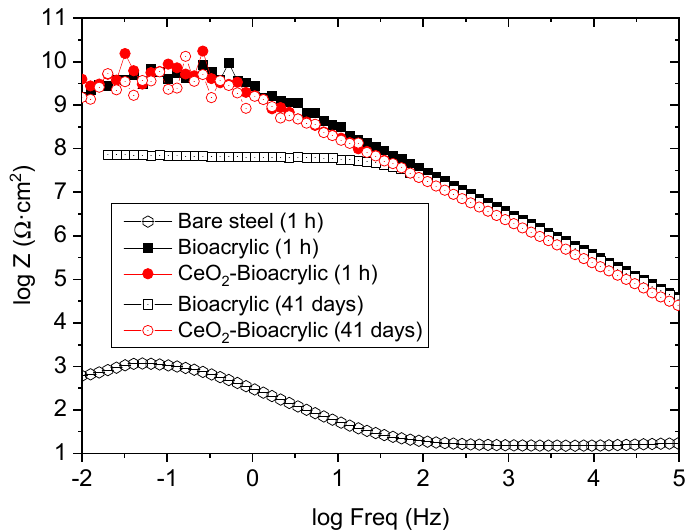
Figure 5. Bode plot of intact binders after 1 h and 41 days of exposure to 3.5 wt% NaCl solution. In order to confirm such hypothesis, an artificial defect has been created by laser on both films. The aim was to reach the metal/film interface in order to explore the inhibition capabilities of CeO 2 nanoparticles [11]. Just immediately after provoking the defect, films were exposed to 3.5 wt% NaCl electrolyte. In addition to the EIS measurement per hour, OCP was monitored with time (Figure 6). Initially (after 10 h), a potential value around − 0.50/ − 0.55 V was obtained for both systems. This potential value is typical of unprotected low carbon steel [36], and it confirms that the artificial defect was able to reach the inter- face. A monotonous increase of the potential was observed for the Bioacrylic film along the entire period of exposure (except for a random increase up to − 0.36V at 65 h), reaching a value of − 0.43 V after 100 h. In contrast, the CeO 2 -Bioacrylic film showed an exponential increase of the potential from − 0.52/ − 0.51 V (11/12 h) up to − 0.02 V (94 h), which is in